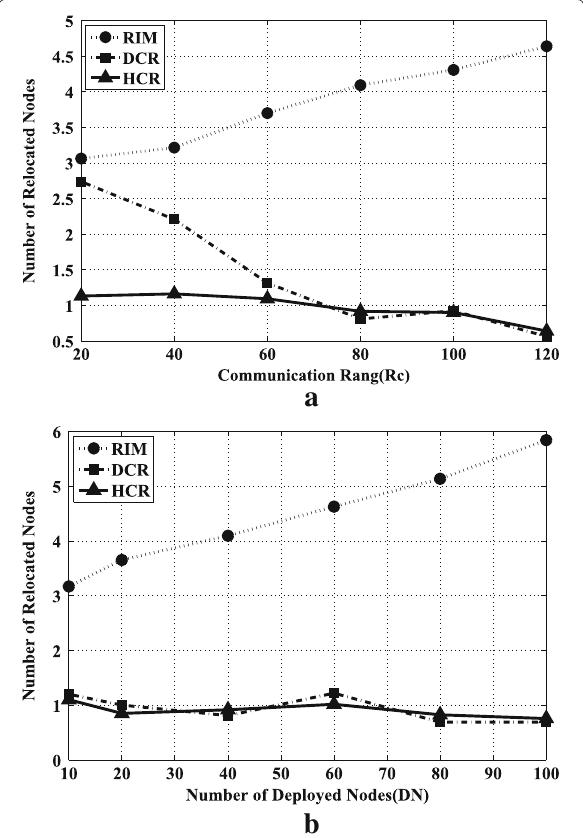
Fig. 9 The number of relocated nodes during the restoration while varying a the communication range (with DN = 40) and b the network size (with R c =